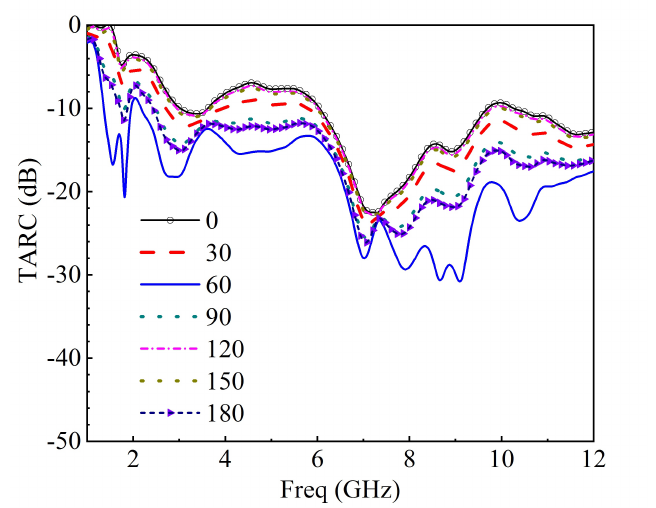
Figure 28. Total active reflection coefficient (TARC) of MIMO antenna system when θ changed from 0 to 180 degrees.